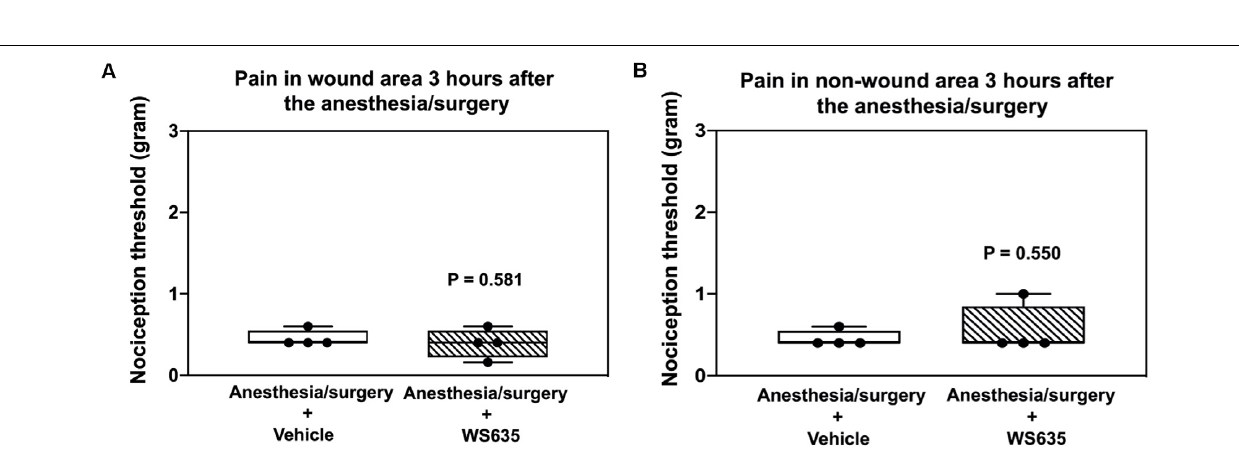
FIGURE 1 | Effects of WS635 on the anesthetic-induced loss of righting reflex in mice. Effects of WS635 and control condition on the presence of loss of righting reflex of mice following different concentrations of isoflurane (A) , sevoflurane (B) , and desflurane (C) . N = 6 mice in each group.